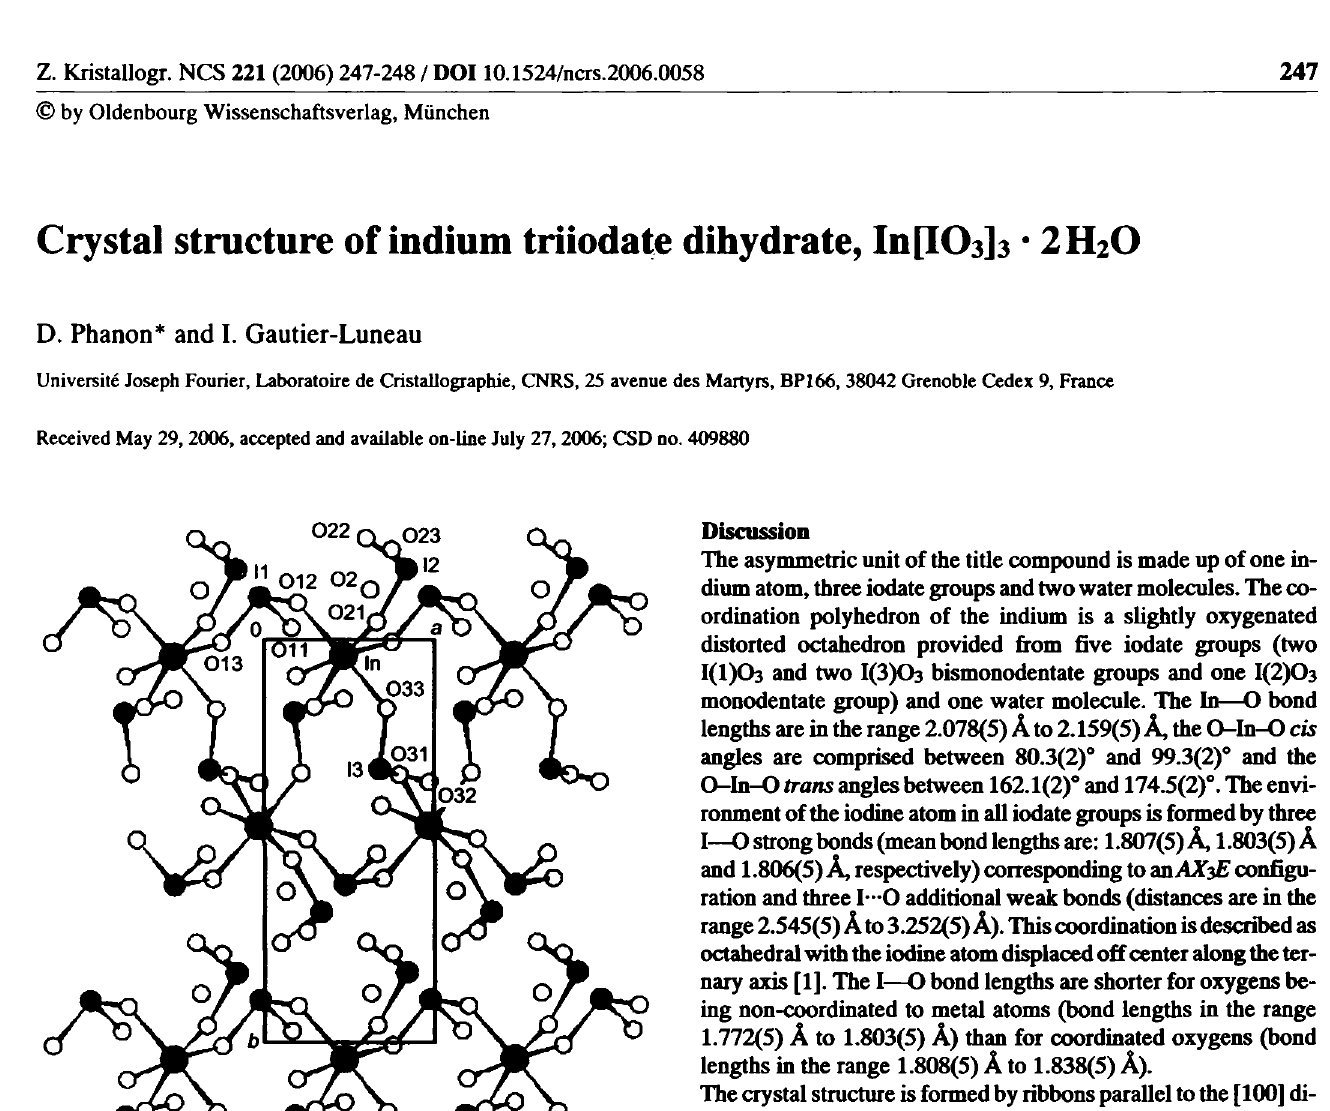
Table 1. Data collection and